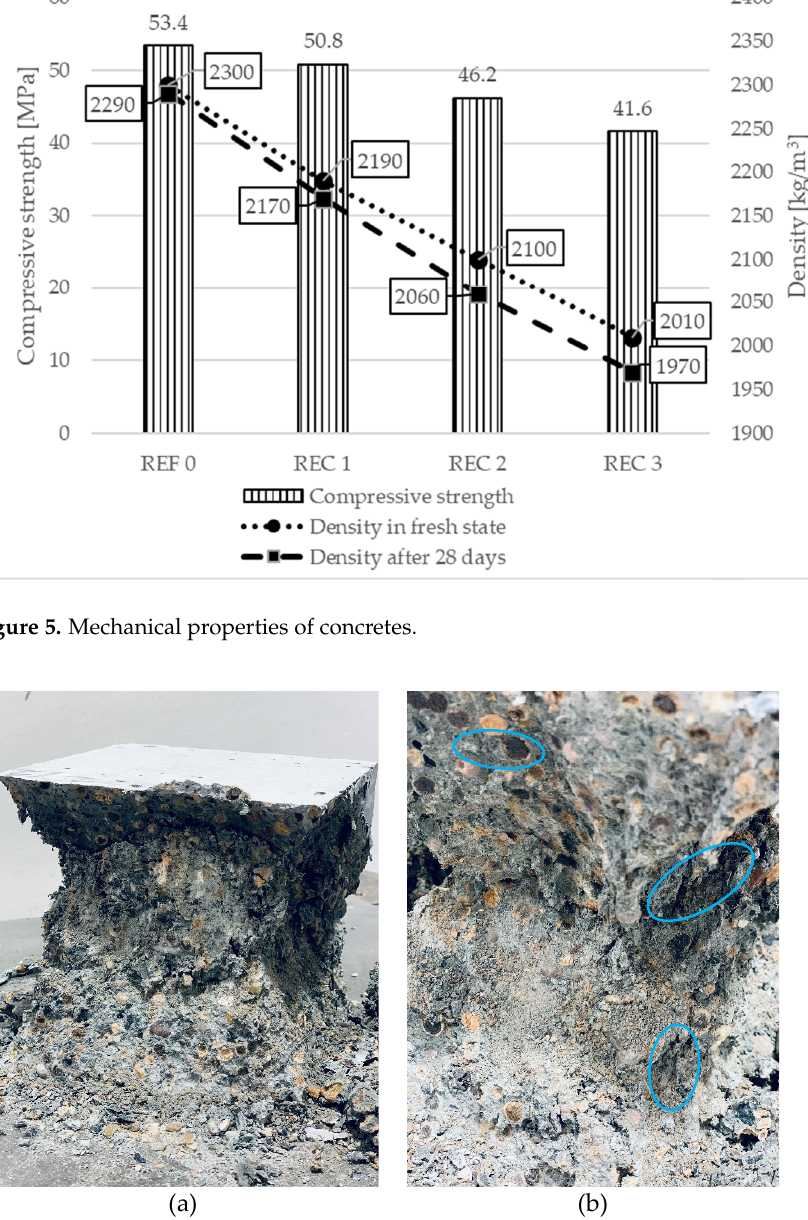
Figure 6. ( a ) Sample of LWC with Agloporite aggregate (REC 2); ( b ) details (blue circle) of moisture inside the LWC structure.